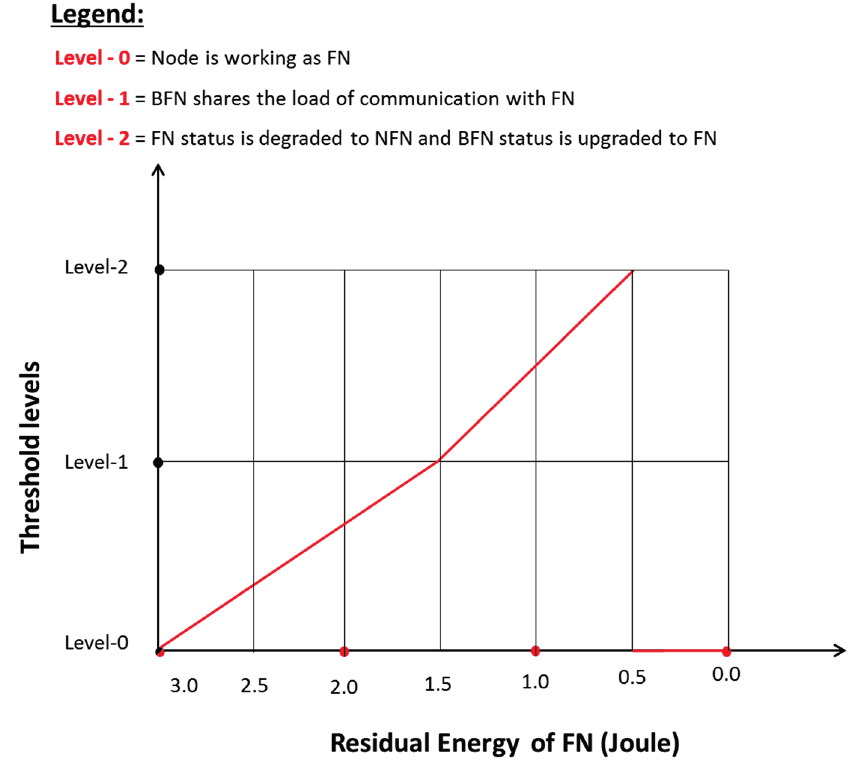
Figure 5. Operation of threshold levels in forwarding node